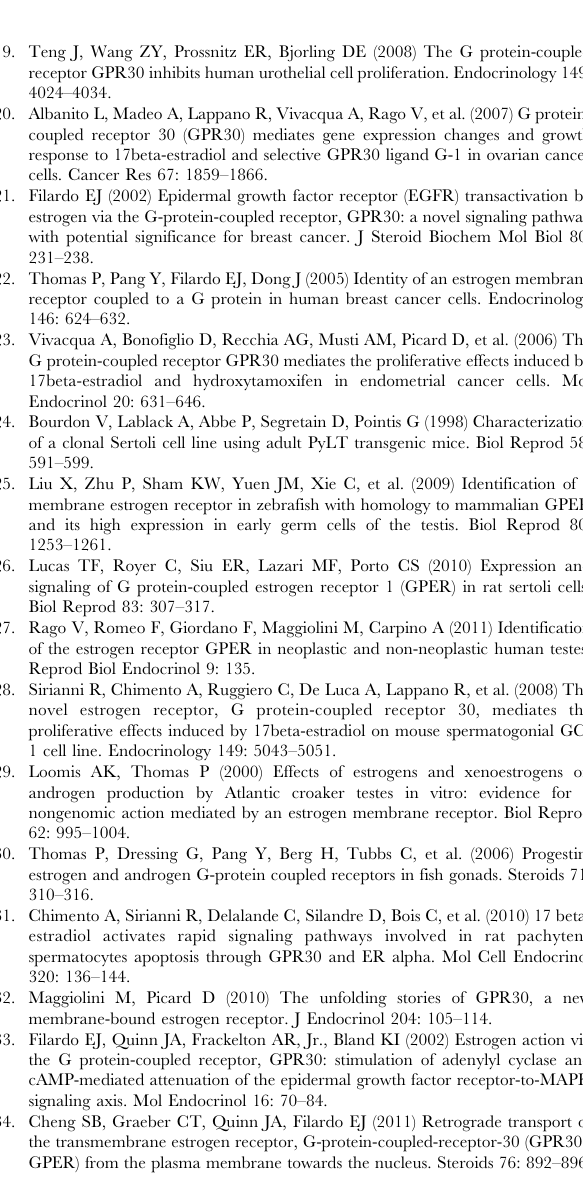
Figure S1 Expression of the G protein-coupled oestro- gen receptor (GPER) in different human malignant testicular germ cell lines. A: Histograms represent relative GPER protein expression related to b -actin, which was taken as a house-keeping gene, analyzed by western blot in different human malignant testicular germ cell lines (JKT-1, a human pure testicular seminoma cell line; NCCIT, a human testicular embryonic carcinoma cell line). 42GPA9, a murine Sertoli